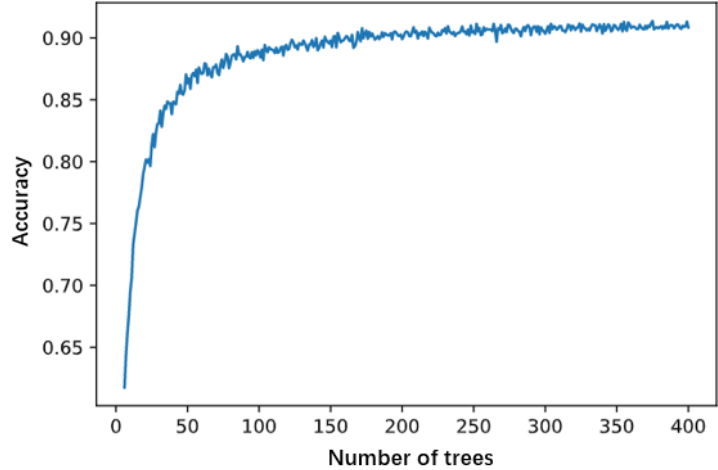
Figure 7. Accuracy of different decision trees in random forest.